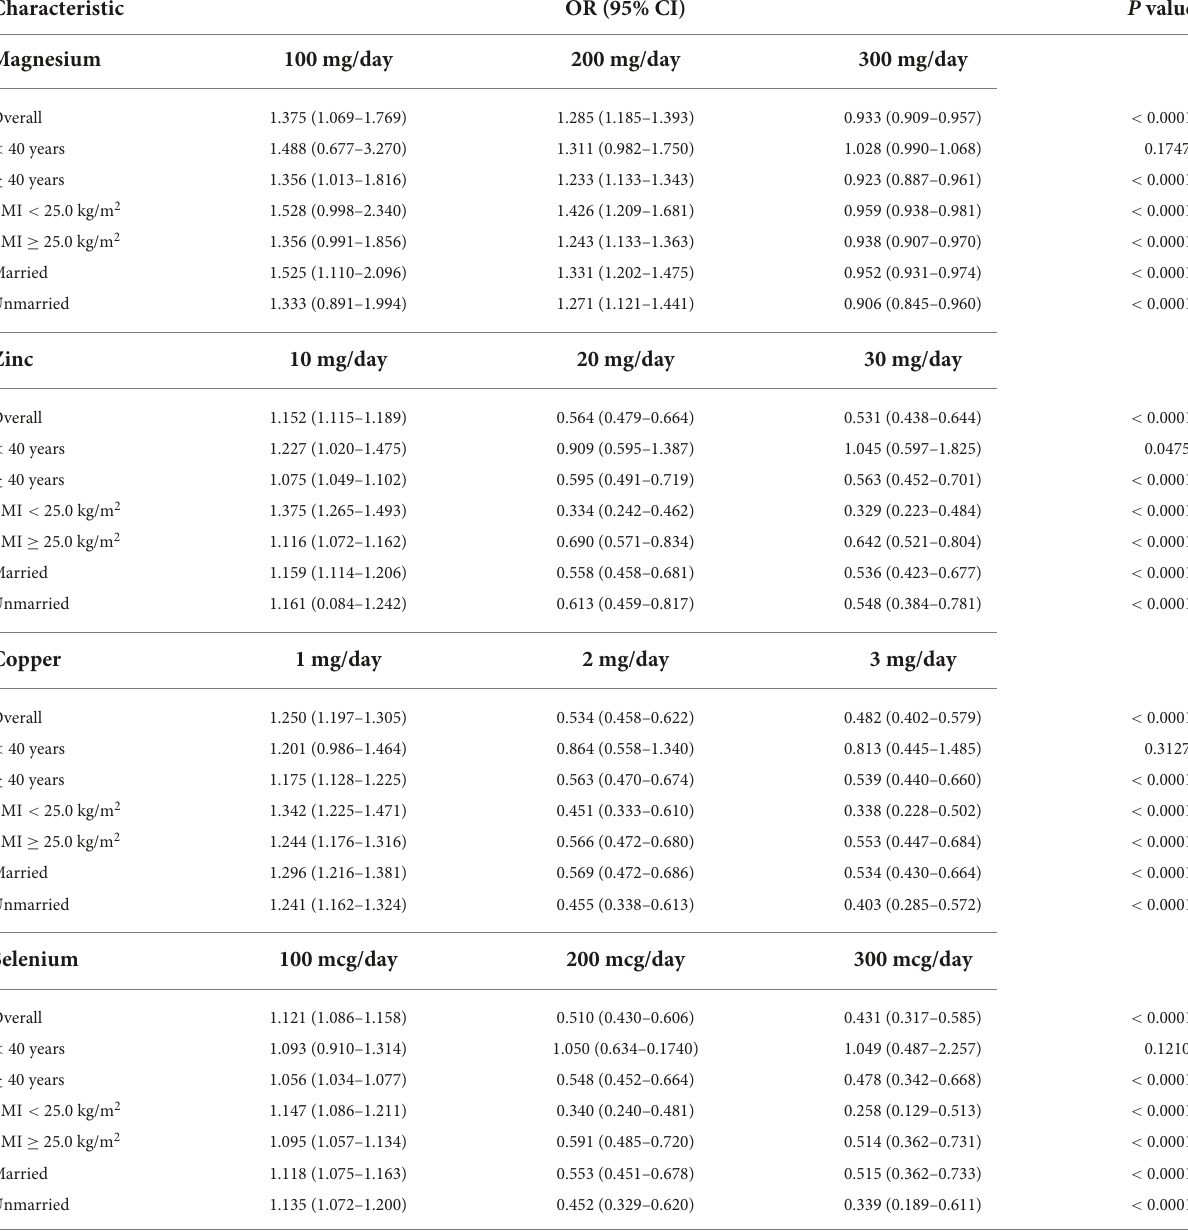
TABLE 2 Subgroup analysis of dietary metal intake and erectile dysfunction in national health and nutrition examination survey (NHANES) 2001–2004 before propensity score matching (PSM).